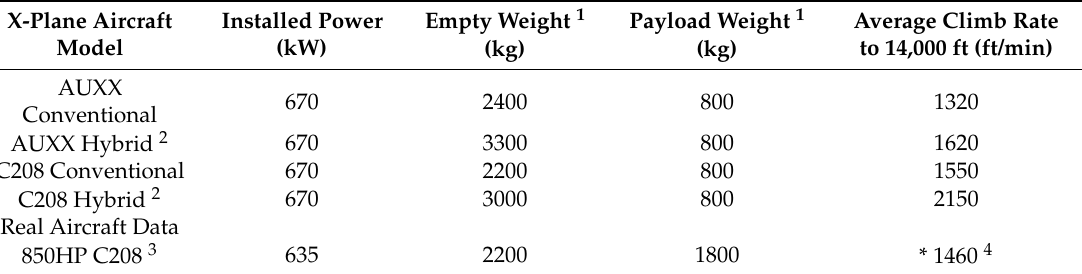
Table 4. X-Plane aircraft simulation model parameters and climb